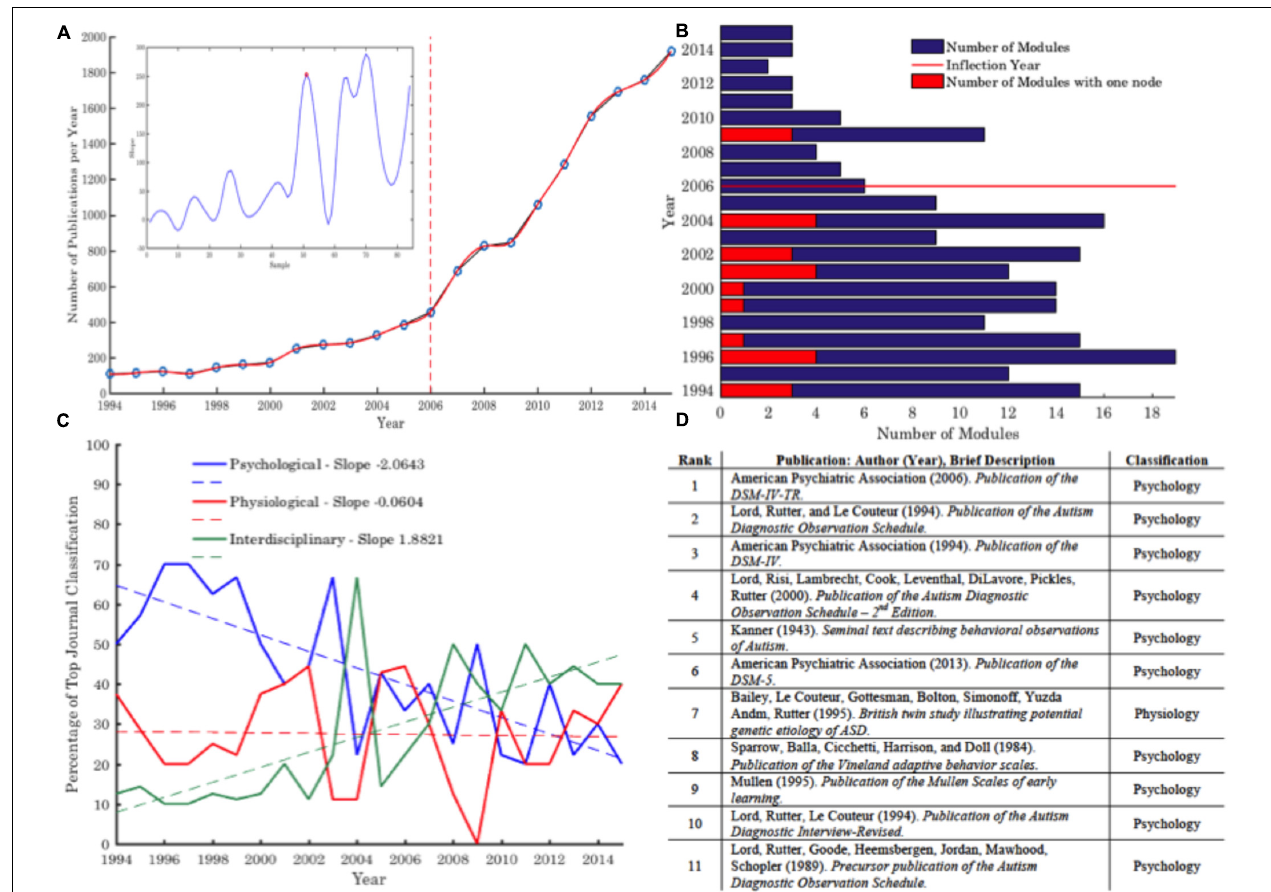
FIGURE 2 | (A) Trend analysis of the number of publications under the topic ‘Autism’ per year, and the critical inflection year highlighted (Slope = (cid:49) y/ (cid:49) x; see inset a). (B) Overview of the number of self-clustered modules identified across the corpus (see section “Keyword Co-occurrence and Modularity: Research Themes – Evolution and Cross Talk”). A number of yearly modules include a single keyword—these are indicated in red. (C) Most frequently occurring journals for publication per year as categorized into broad thematic silos: Psychological, Physiological and Interdisciplinary, and related empirically estimated trend lines. (D) Classification of top cited publications across the corpus 1994–2015 demonstrates the prevalence of Psychological research and tools. See Supplementary Tables 1 – 3 for further information on this classification trend as decomposed to the decade level. For larger high resolution figures please see